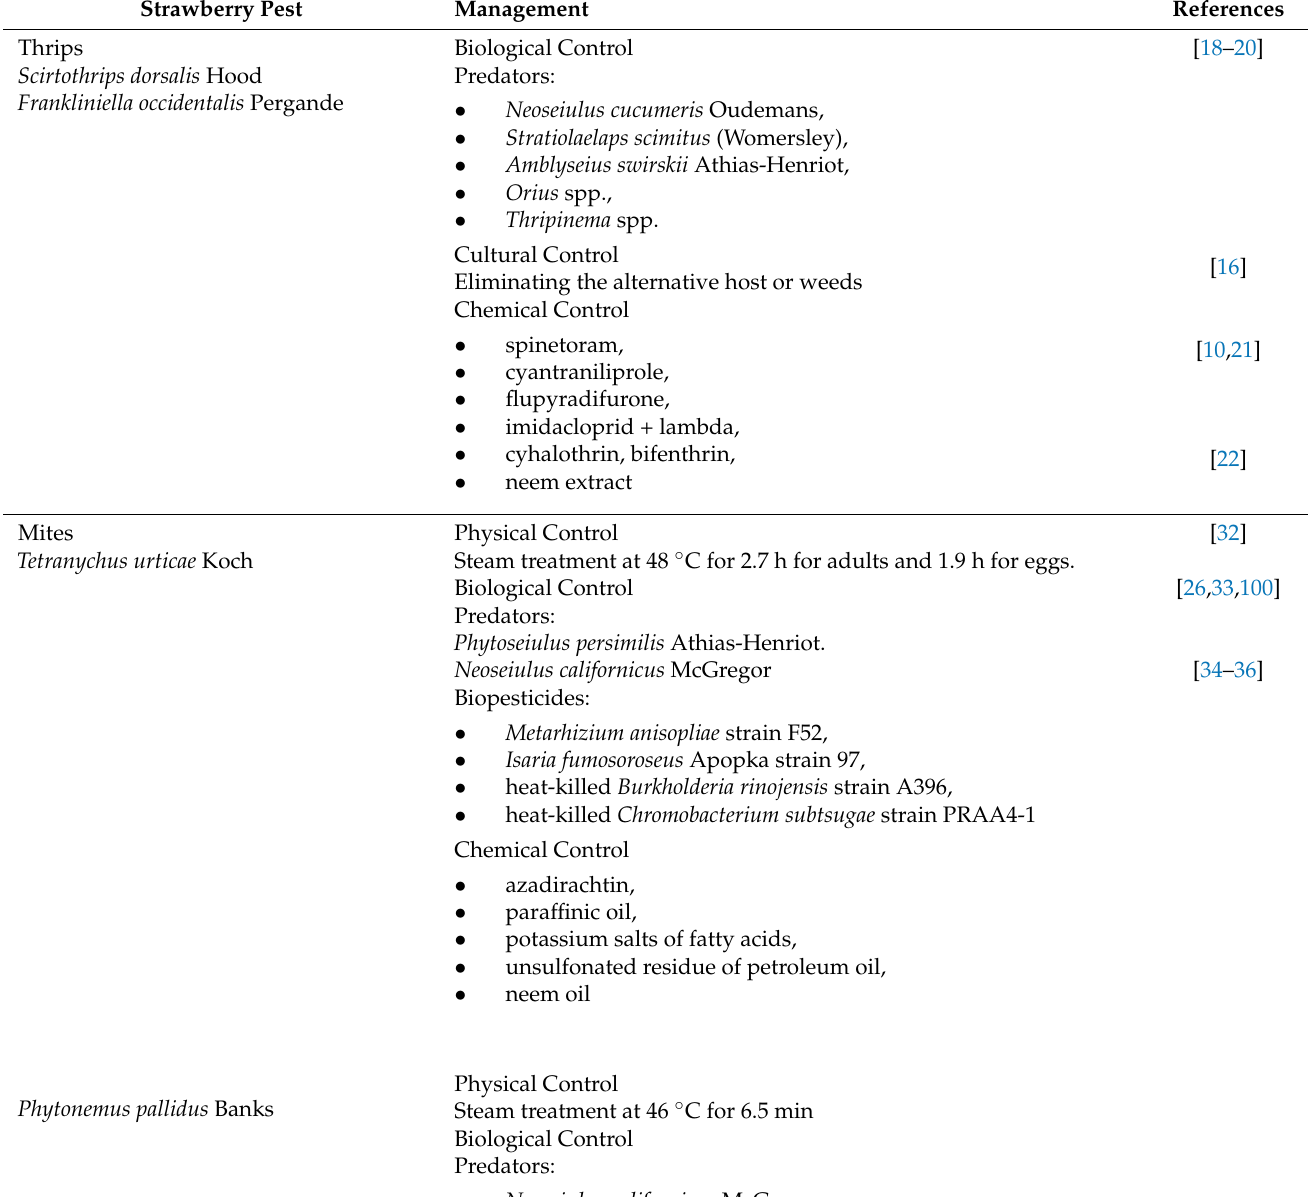
Table 1. Summary table of pest management techniques for strawberry